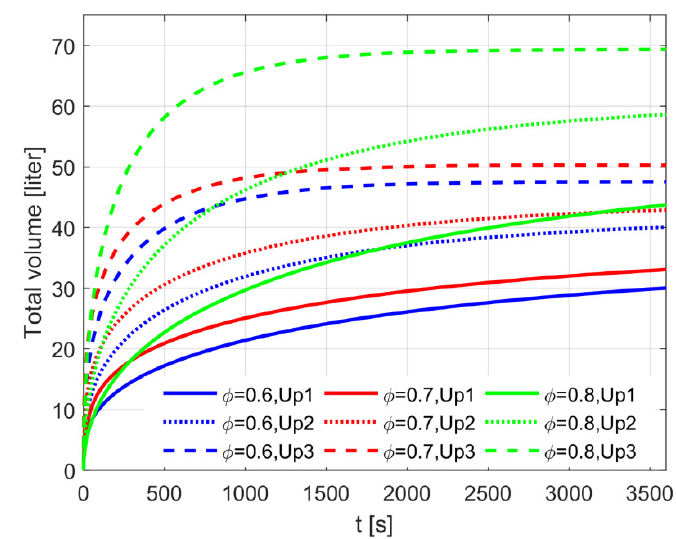
Figure 10. The water uptake [L] as a function of time [s] for combinations of the three porosities and the cases Up1–3. Graph lines: solid Up1, dotted Up2, dashed Up3. Graph colors: blue ϕ = 0.6, red ϕ = 0.7, green ϕ = 0.8.